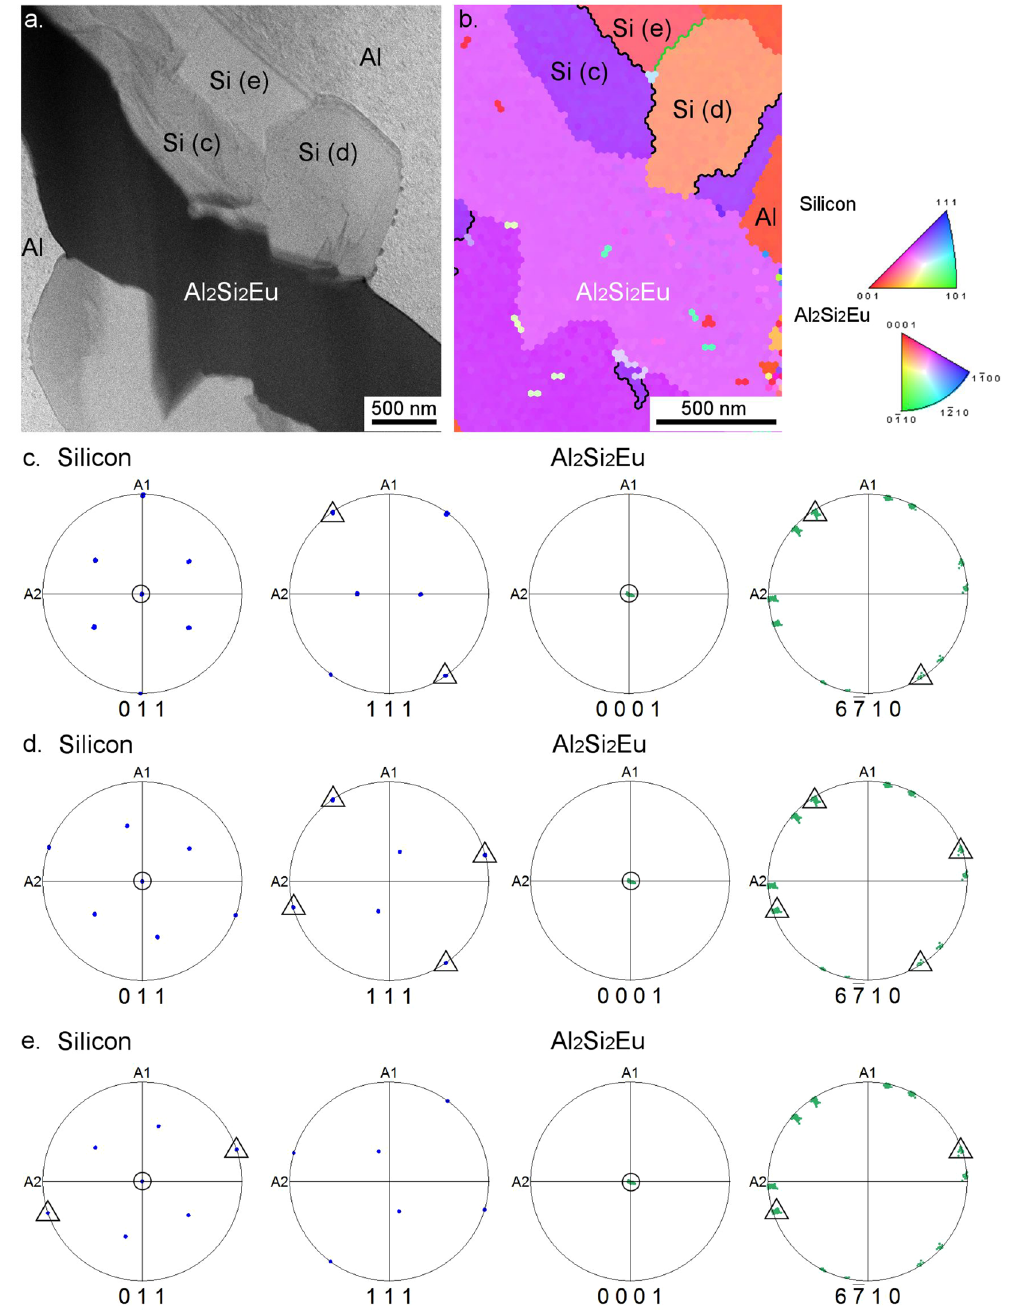
Figure 5. Crystallographic orientation relationship between Si and eutectic Al 2 Si 2 Eu: ( a ) bright field TEM image showing eutectic Al 2 Si 2 Eu surrounded by Si; ( b ) inverse pole figure of a TKD map showing mutually twinned Si crystal orientations. Black boundaries between Si grains show ∑ 3 twin (60° @ < 111 > ), and the green boundary highlights a ∑ 9 twin (38.9° @ < 110 > ). ( c – e ) Pole figures (PF) corresponding to the three Si crystals marked in ( b ). All PF were re-oriented to the (0001) Al2Si2Eu in the normal direction (ND) for convenience. Circles depict coincident poles (parallel plane-normals) between 011 Si and 0001 Al2Si2Eu . Triangles depict coincident poles in 011 Si , 111 Si and 6 7 10 Al2Si2Eu